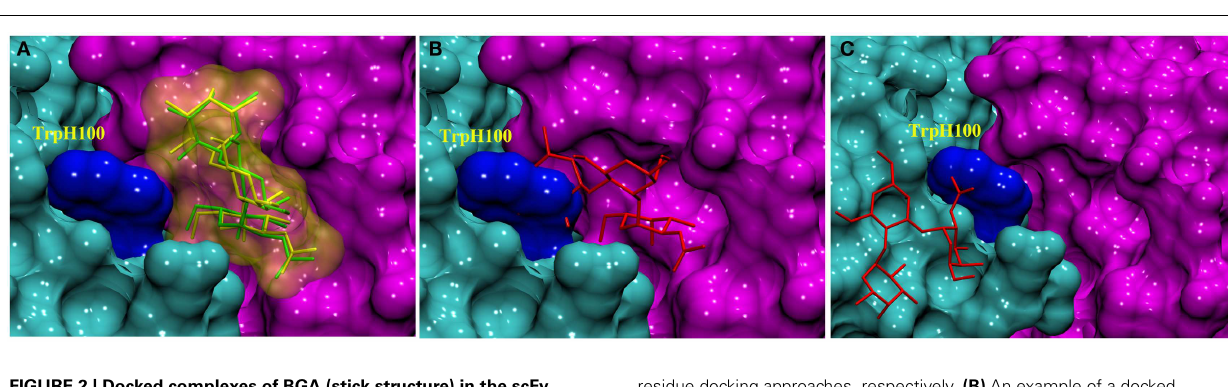
FIGURE 2 | Docked complexes of BGA (stick structure) in the scFv binding site (heavy and light chains shown as solvent accessible surfaces in cyan and pink, respectively, theTrp H100 surface is shown in dark blue) . (A) The stick structures in green and yellow represent the best-docked poses from theTrp H100 -mutagenesis and the flexible